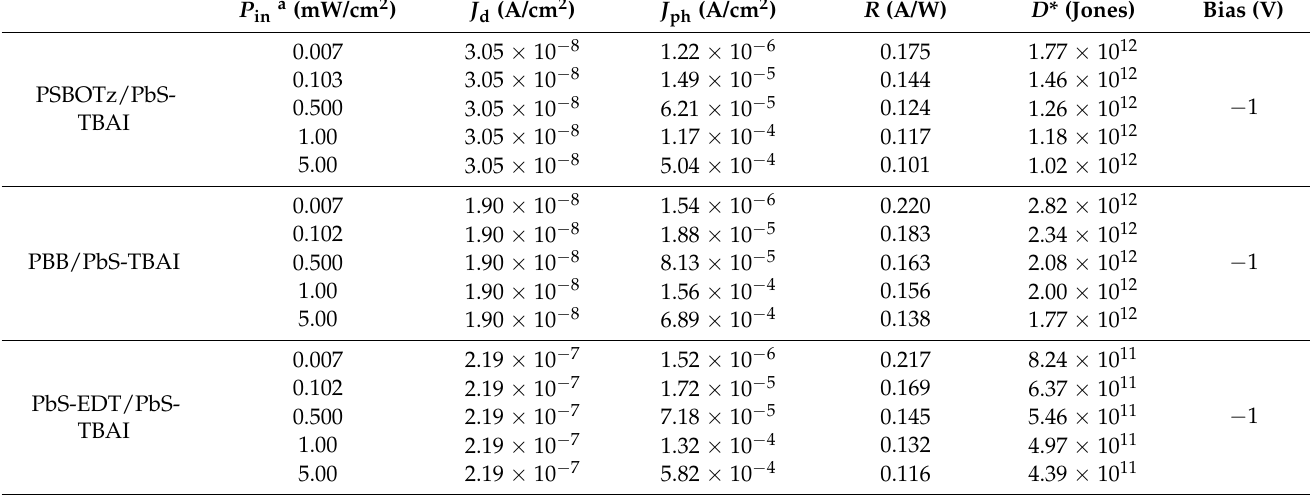
Figure 2. ( a ) Schematic of the fabricated device structure. J–V curves of the device with ( b ) PS- BOTz, ( c ) PBB, and ( d ) PbS-EDT-based devices. ( e ) SCLC plots using a hole-only device (ITO/PEDOT:PSS/CP or PbS-EDT/MoO X /Ag). ( f ) V OC vs. P light plots of fabricated devices. ( g ) J ph vs. V eff plots under 100 mW/cm 2 for 940 nm LED illumination. Table 1. Summary of QPD